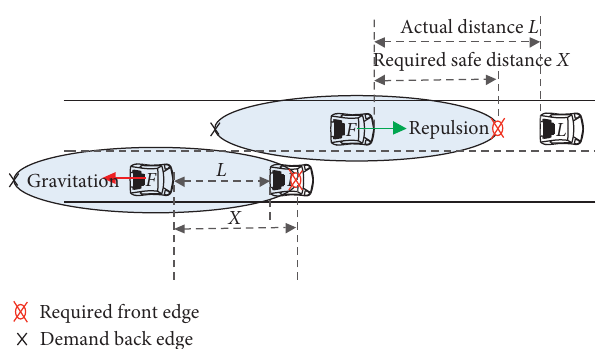
Figure 1: Molecular forces.